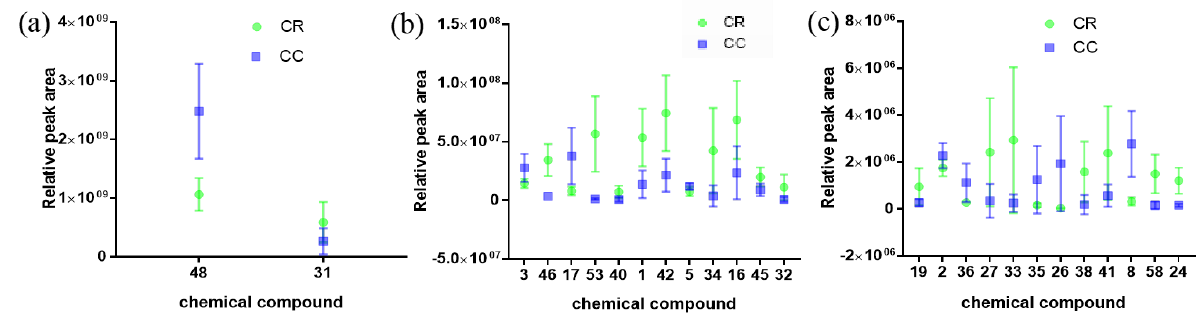
Figure 6. Box plots of the relative intensities of CR and CC: ( a ) compounds 48 and 31 with peak areas of 3.52 × 10 7 ~3.17 × 10 9 ; ( b ) compounds 3 , 46 , 17 , 53 , 40 , 1 , 42 , 5 , 34 , 16 , 45 and 32 with peak areas of 4.80 × 10 5 ~1.48 × 10 8 ; and ( c ) compounds 19 , 2 , 36 , 27 , 33 , 35 , 26 , 38 , 41 , 8 , 58 and 24 with peak areas of 3.15 × 10 4 ~6.15 × 10 6 .